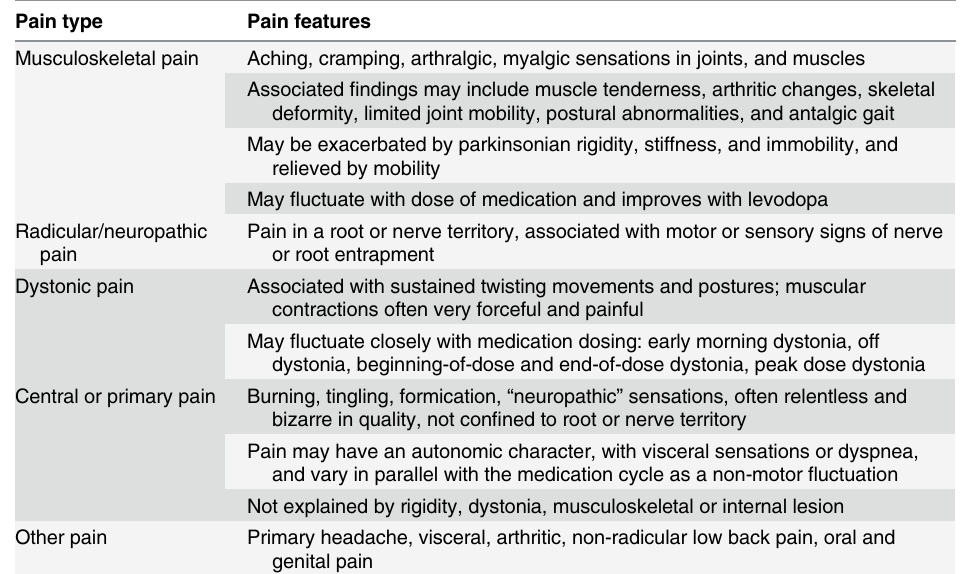
Table 2. Ford ’ s pain classification.